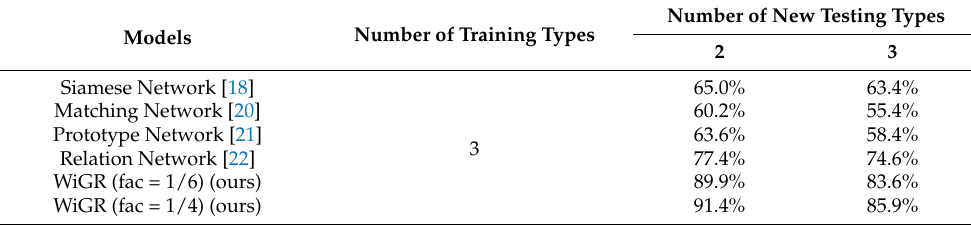
Table 6. Accuracy of recognizing new types of gestures with three samples using the CSIDA data